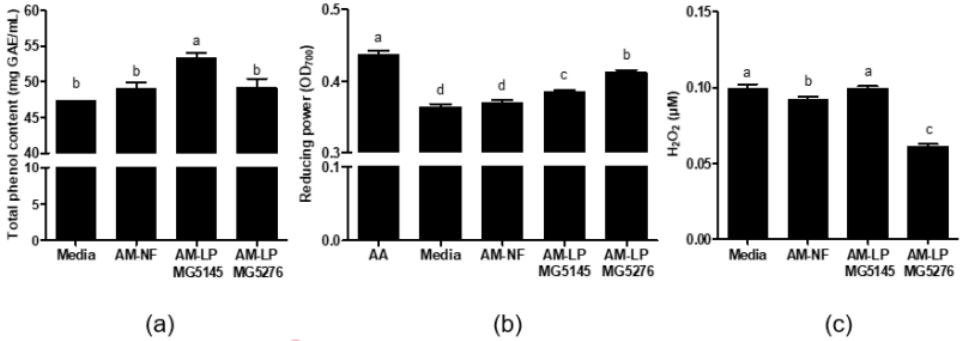
Figure 2. ( a ) Total phenol content (TPC) ( b ) reducing power, and ( c ) total H 2 O 2 content of AM-NF,